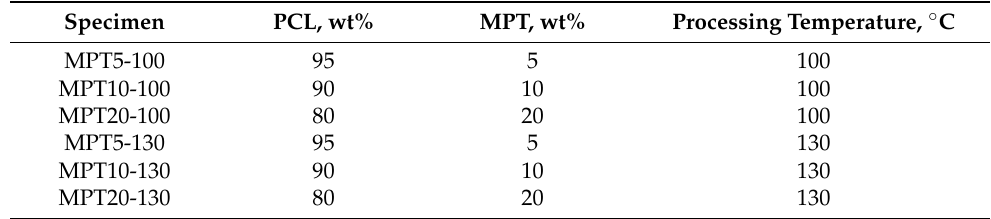
Table 1. The formulation of PCL/MPT